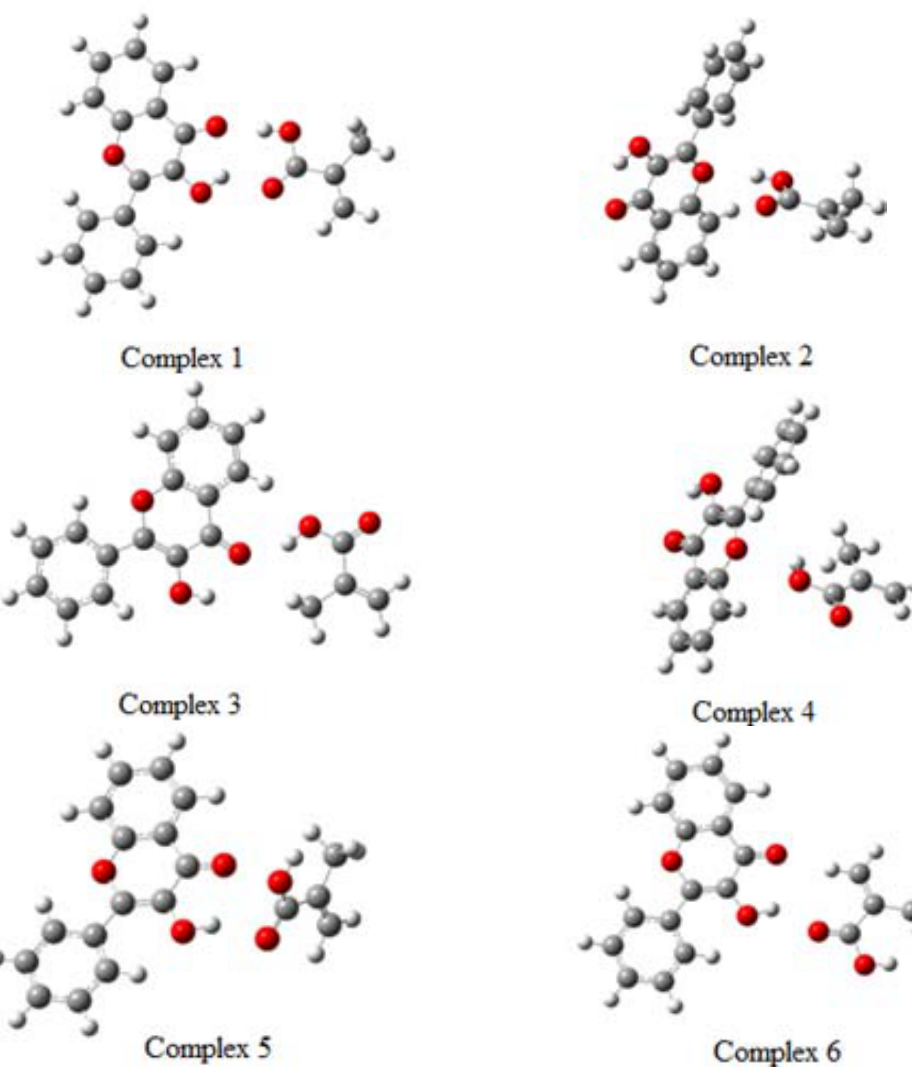
Figure 5. Pre-polymerization complexes proposed in a FL-MAA molecular ratio